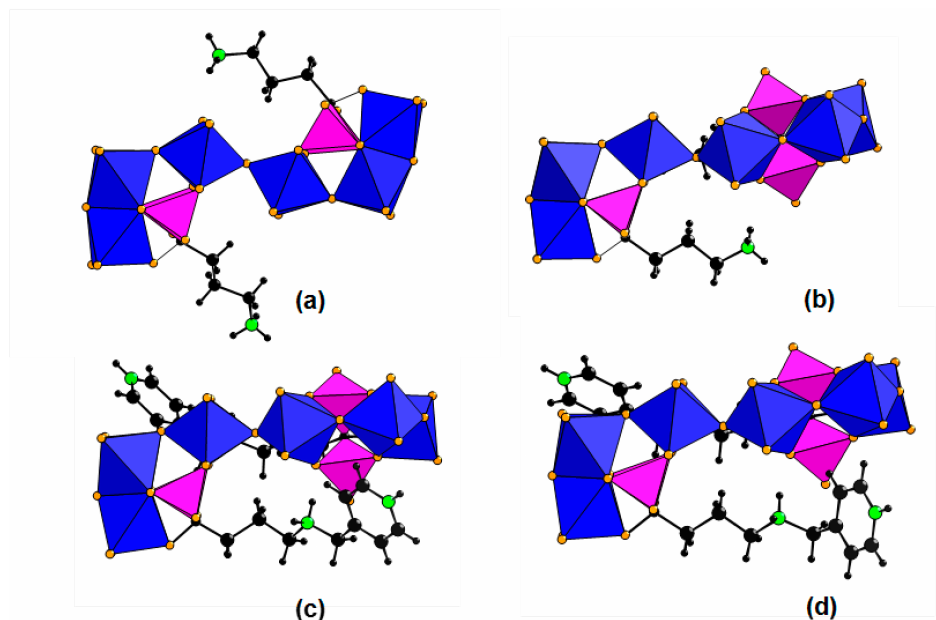
Figure 3. Mixed polyhedral/ball-and-stick representation of the hexanuclear POM of general formula [(Mo VI 3 O 8 ) 2 (O)(BP) 2 ] n − in ( a ) Rb 0.25 (NH 4 ) 5.75 [(Mo VI 3 O 8 ) 2 (O)(Ale) 2 ] 18 ( A conformation), ( b ) Na 6 [(Mo VI 3 O 8 ) 2 (O)(Ale) 2 ] 24 ( B conformation), ( c ) NaMo 6 (Ale-4Py) 2 and ( d ) NaKMo 6 (Ale-4Py) 2 ; blue octahedra: Mo VI O 6 , pink tetrahedra: PO 4 , orange spheres: O, black spheres: C, green spheres: